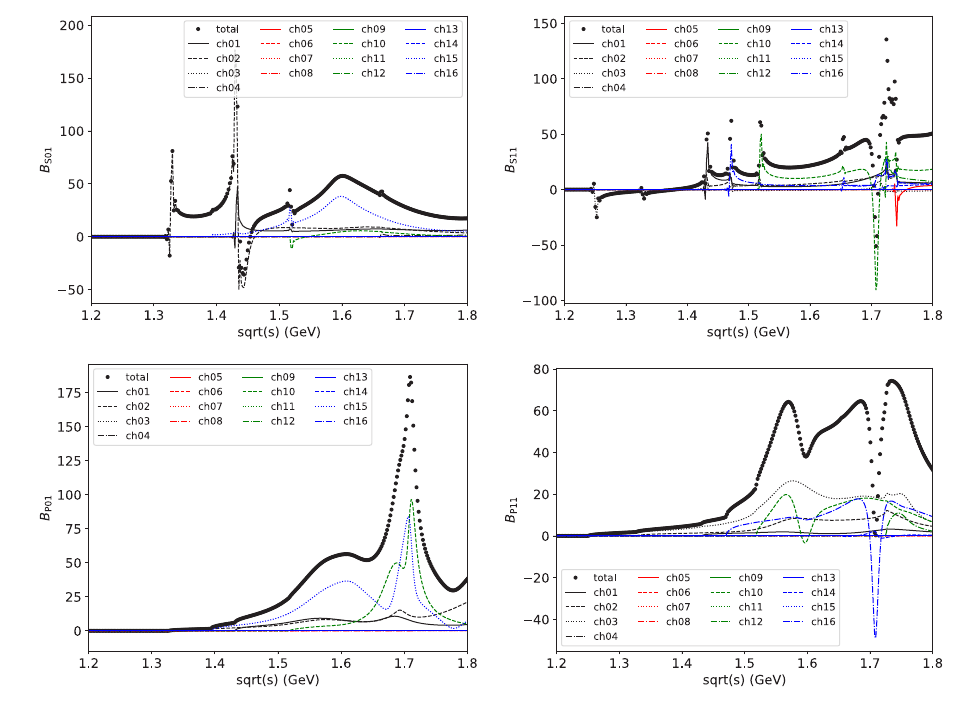
Figure 1. The e ff ective spectral function (with its channel components) as a function of center of mass energy: for S01, S11, P01, and P11 partial waves. See Ref. [8] for details.